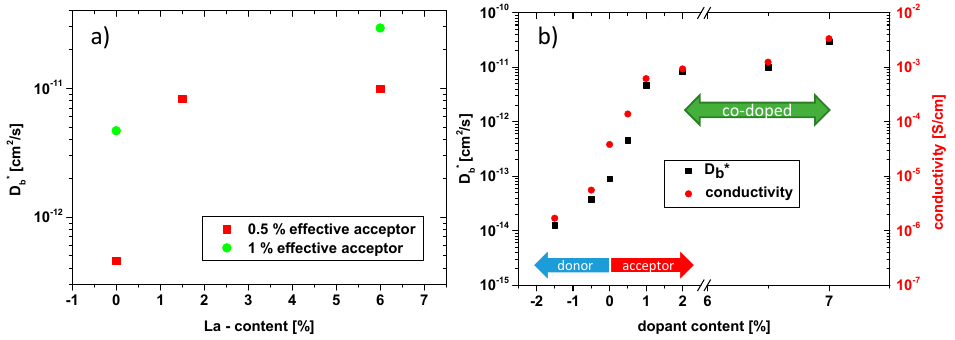
Figure 11. ( a ) Bulk diffusion coefficients of PZT at 560 °C with effective acceptor concentrations of 0.5% and 1%, drawn as function of the La content; ( b ) summary of all bulk diffusion coefficients and hole conductivities in ambient air, measured at 560 °C. For co-doped and acceptor doped samples the abscissa indicates the Fe content.